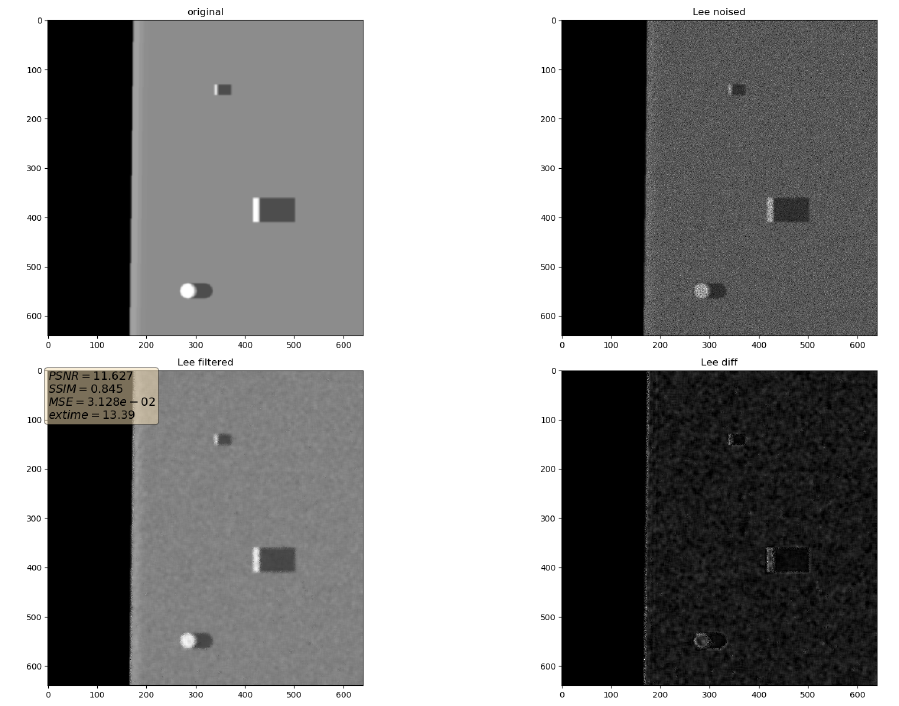
Figure 12. Filtering results for Lee filter. Speckle noise σ 2 = 0.05.